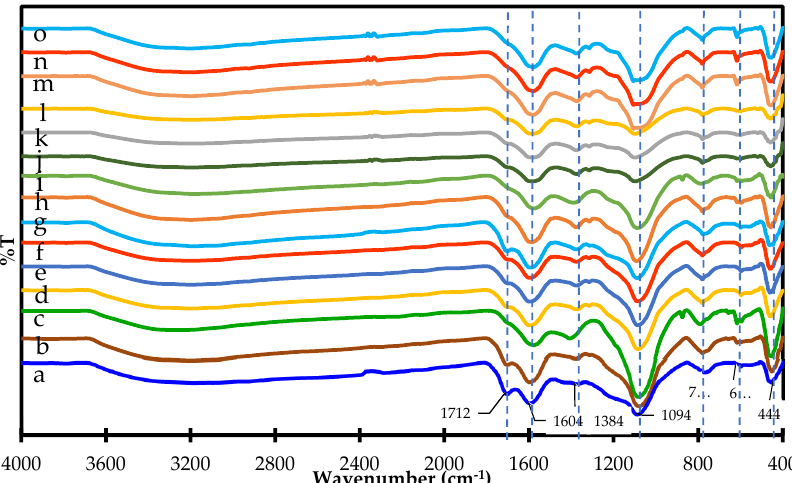
Figure 3. FTIR transmission of ( a ) activated carbon w/t HTP prepared at 300 °C; ( b ) activated carbon